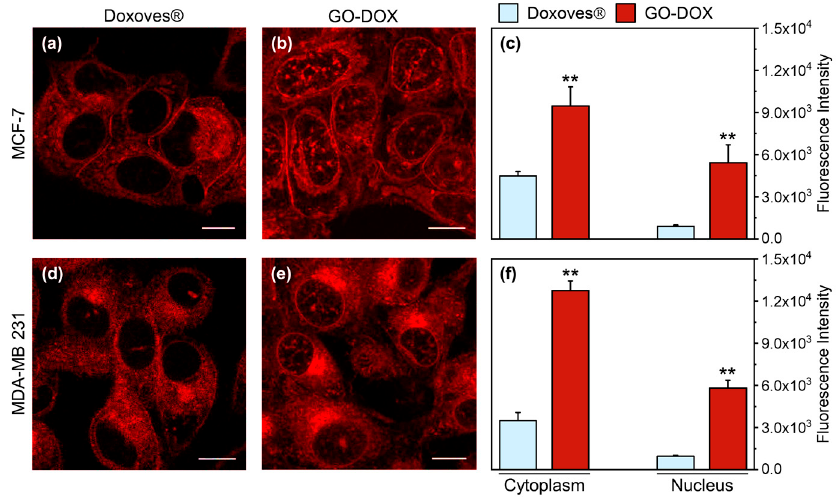
Figure 3. Representative confocal microscopy images of MCF-7 cells treated with ( a ) Doxoves ® and ( b ) doxorubicin (DOX)-loaded GO sheets GO-DOX complexes (GO / DOX weight ratio, Rw = 0.33). Experiments were performed at high DOX concentration (i.e., = 13 µ g / well). ( c ) Fluorescence intensity analysis of the intracellular localization of DOX. ( d – f ) Analogously, confocal imaging and analysis were performed in MDA-MB 231 cells. Statistical significance was evaluated using a Student’s t -test (** p < 0.01) with respect to Doxoves ® . Calculations reported in panels c and f were made using not less than 60 randomly selected cells. Scale bars are 10 μ m.